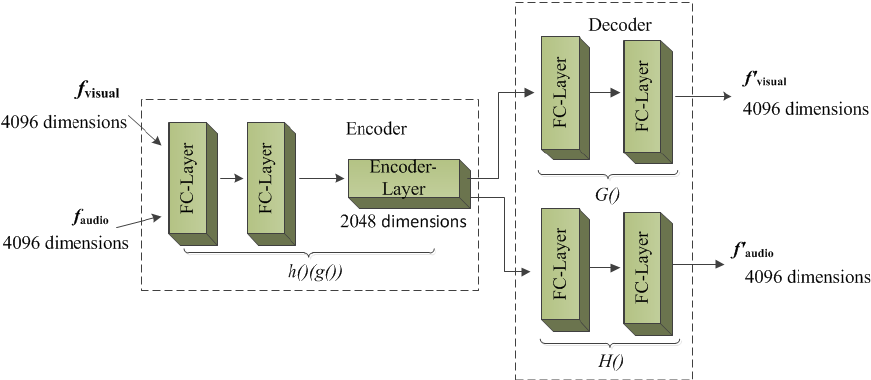
Figure 3. Autoencoder model.